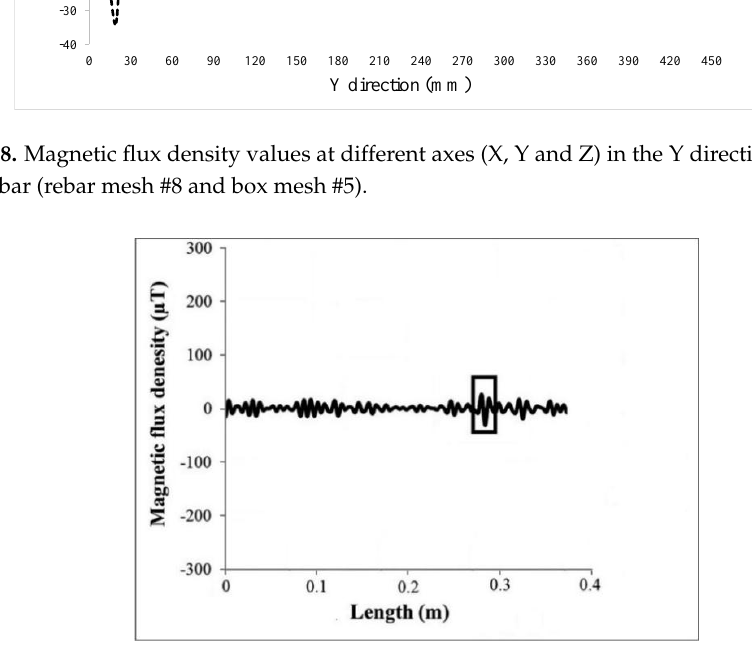
Figure 19. X-component of magnetic flux density resulting from the previous experiments; the square shows the Hole 2 location (modified from Mahbaz et al, 2017 [37]).